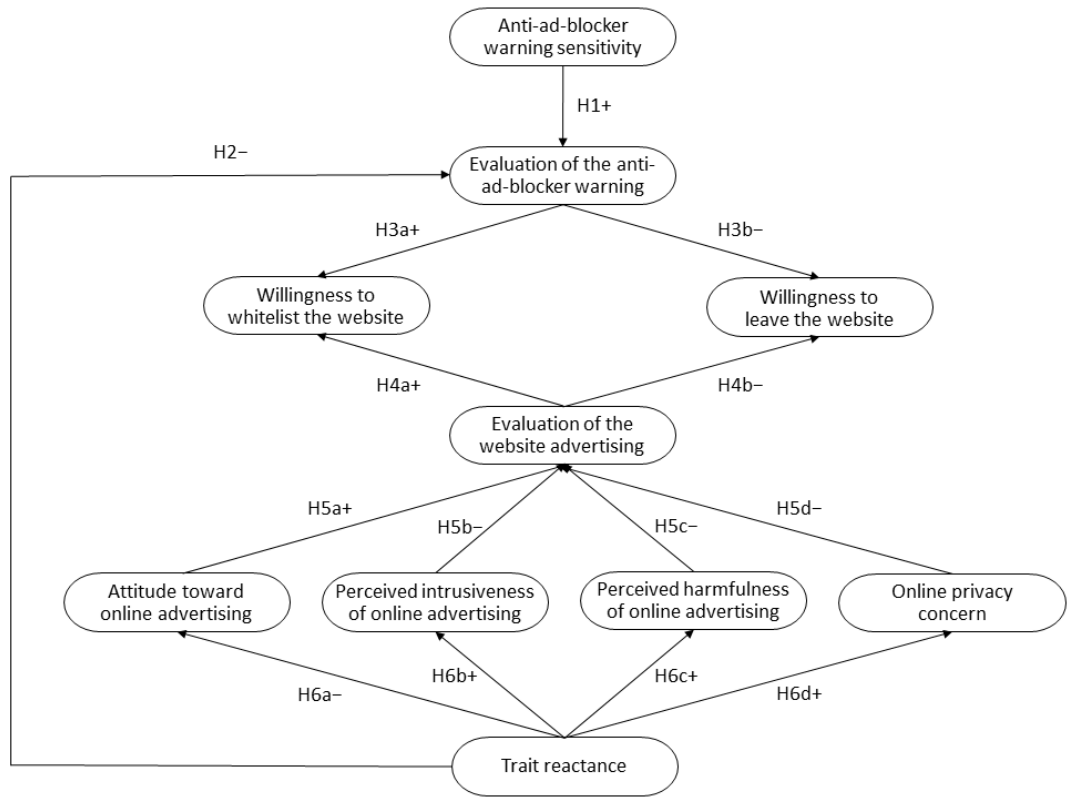
Figure 1. Hypothesized structural